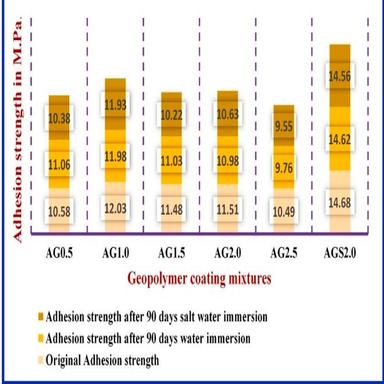
Change in adhesion strength of samples after 90 days static water and static salt water immersion at room temperature.